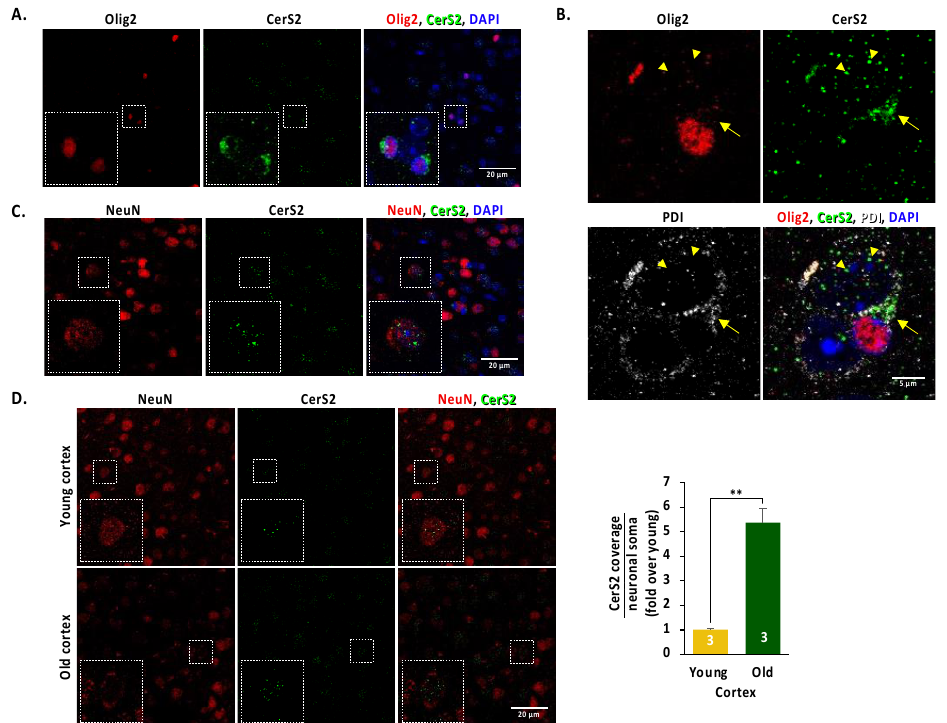
Figure 2. Immunolocalisation analysis of CerS2 of the mice brain cortex. ( A ) Perinuclear localisation of CerS2 in Olig2 positive cells showing CerS2 is expressed in oligodendrocytes. ( B ) Colocalisation of CerS2 with the endoplasmic reticulum (ER) marker PDI and Olig2 positive oligodendrocytes. Triangles point to a punctuate pattern in nuclei and perinuclear area resemblant to the one found in neurons. Arrow points to CerS2 diffuse pattern that colocalises with PDI perinuclear staring typical of ER. ( C ) CerS2 punctuate pattern in NeuN positive neurons. ( D ) Analysis of CerS2 punctuate pat- tern area per neuronal soma in the young and old cortex shows increased CerS2 levels in the aged neurons. Student t-test. ** p -value < 0.01.